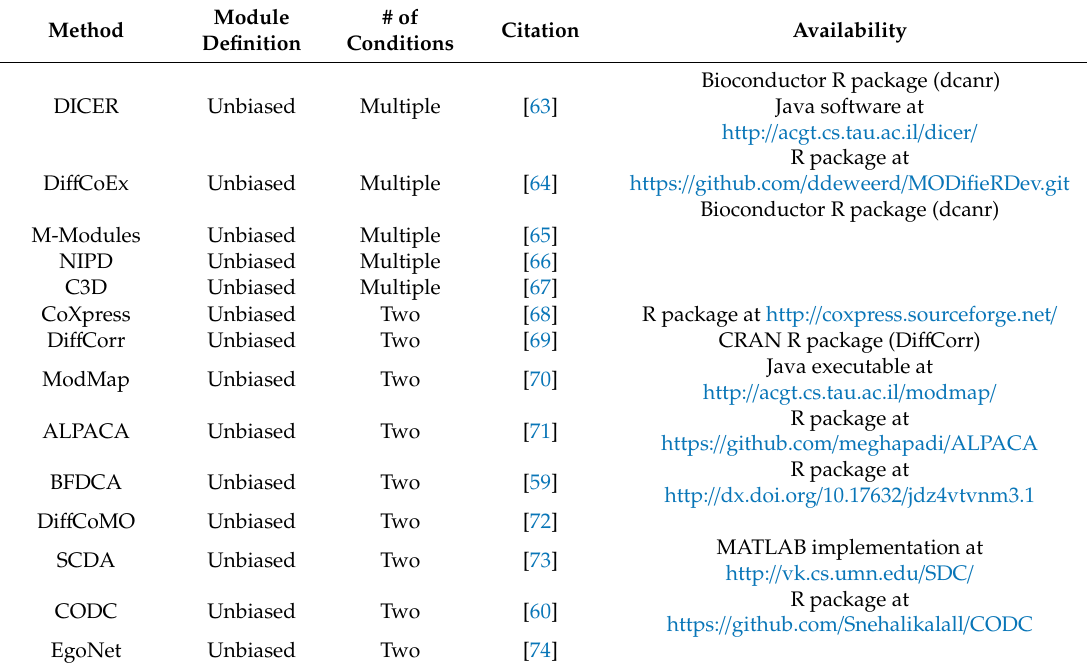
Table 3. “Module-based”